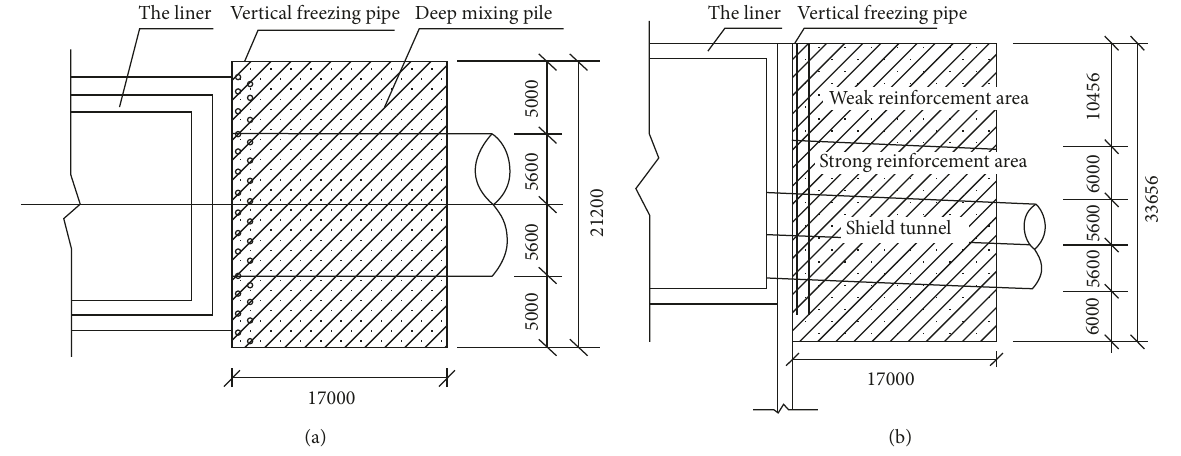
Figure 2: Practical improvement method and area (unit: mm). (a) Plane view; (b) cross section.